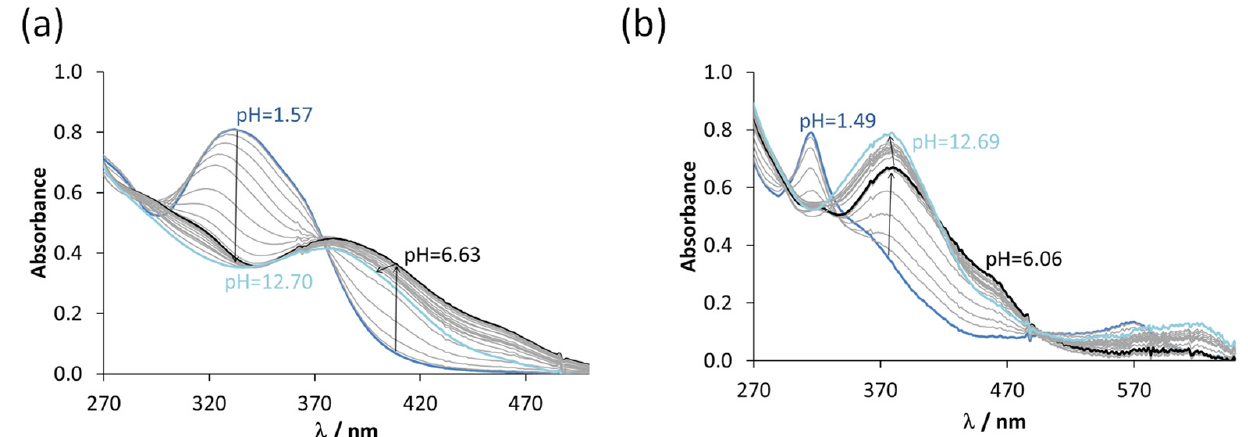
Figure 2. UV - vis spectra of the ( a ) iron(III)–COTI-2 (1:2) and ( b ) iron(II)–COTI-NMe 2 (1:2) systems recorded at various pH values; ( a ): c L = 20 µM and c Fe(III) = 10 µM; ( b ): c L = 30 µM, c Fe(II) = 15 µM, T = 25 °C, I = 0.10 M (KCl), ℓ = 2.0 cm, and 30% ( v/v ) DMSO/H 2 O. Table 2. Overall stability constants (log β ) of the iron(III/II) complexes and formal redox potentials ( E ’) of the iron(III)–ligand (1:2)